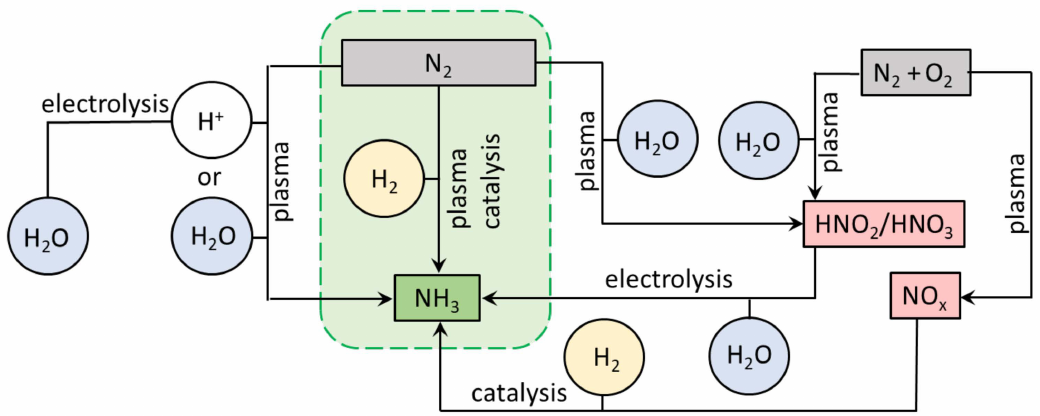
Figure 1. Various pathways of plasma-driven NH 3 production from N 2 . The green frame focuses on plasma catalysis described in this